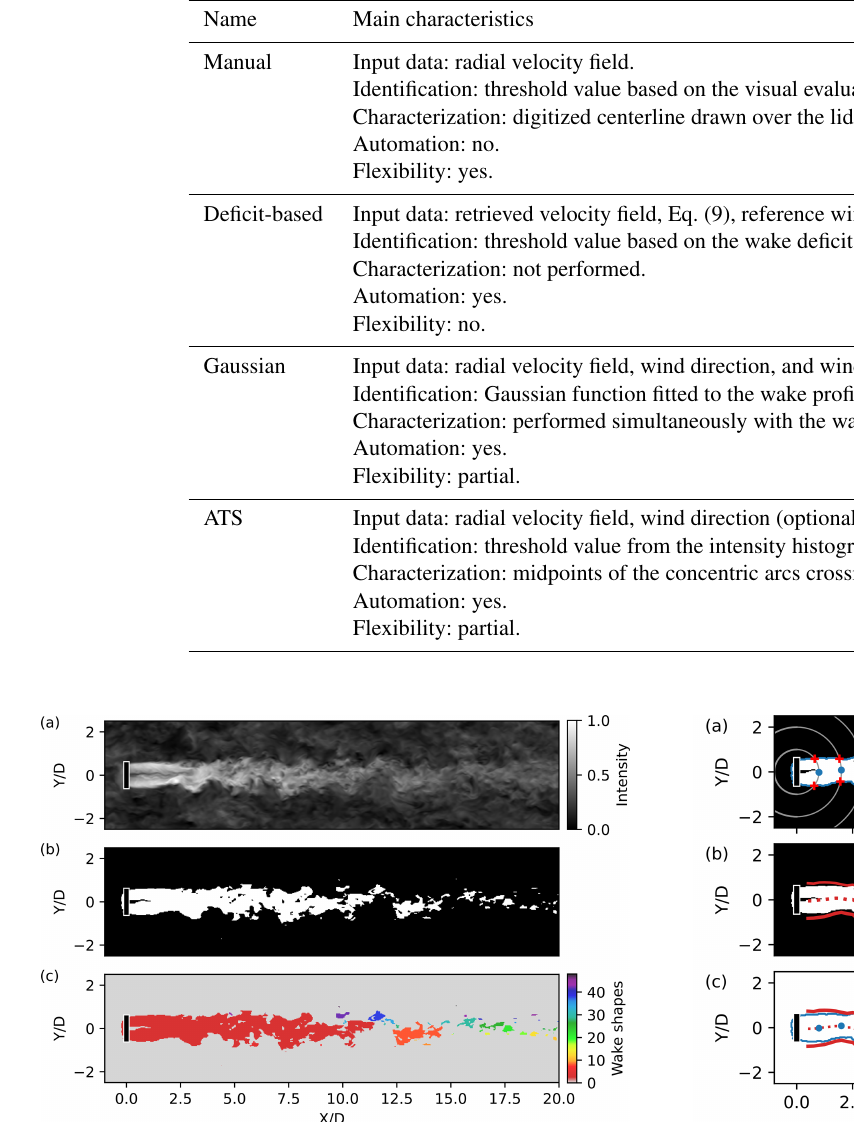
Table 2. Summary of the wake detection methods.